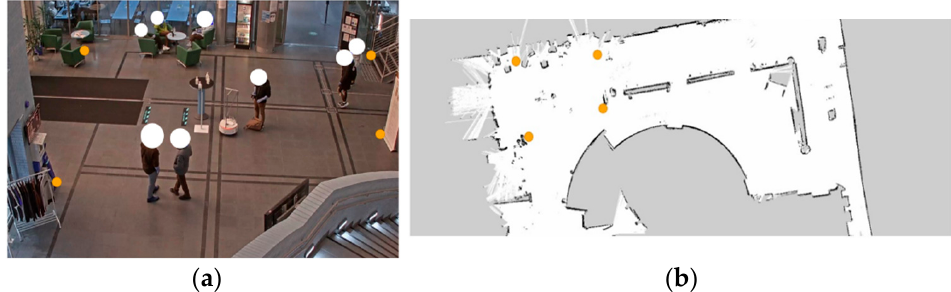
Figure 4. CCTV camera calibration: Yellow markers represent ( a ) pixel coordinates in angled view; ( b ) Cartesian coordinates in top view.